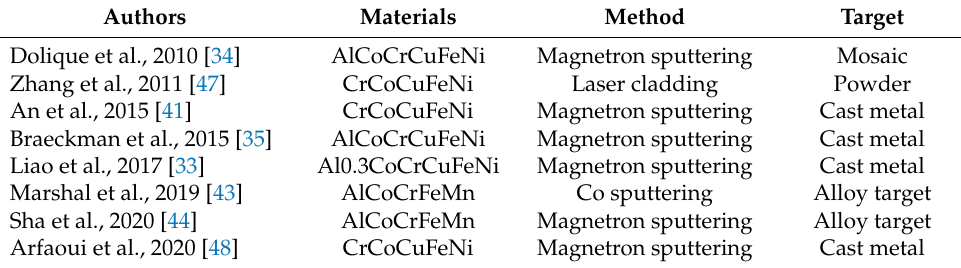
Table 1. Summary of previous studies on CoCr-based HEA coatings/thin